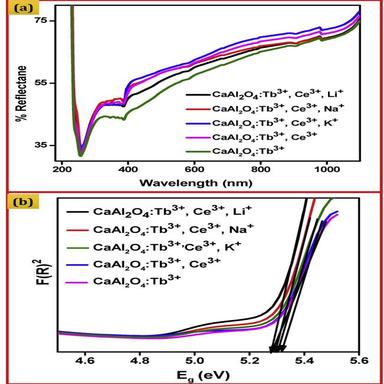
(a). DR spectra and (b) optical energy band gap of the optimized NPs.